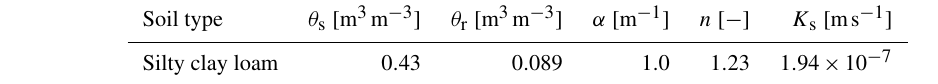
Table C2. Hydraulic properties of the silty clay loam soil (Bonan, 2019) for the Horton runoff numerical experiment.